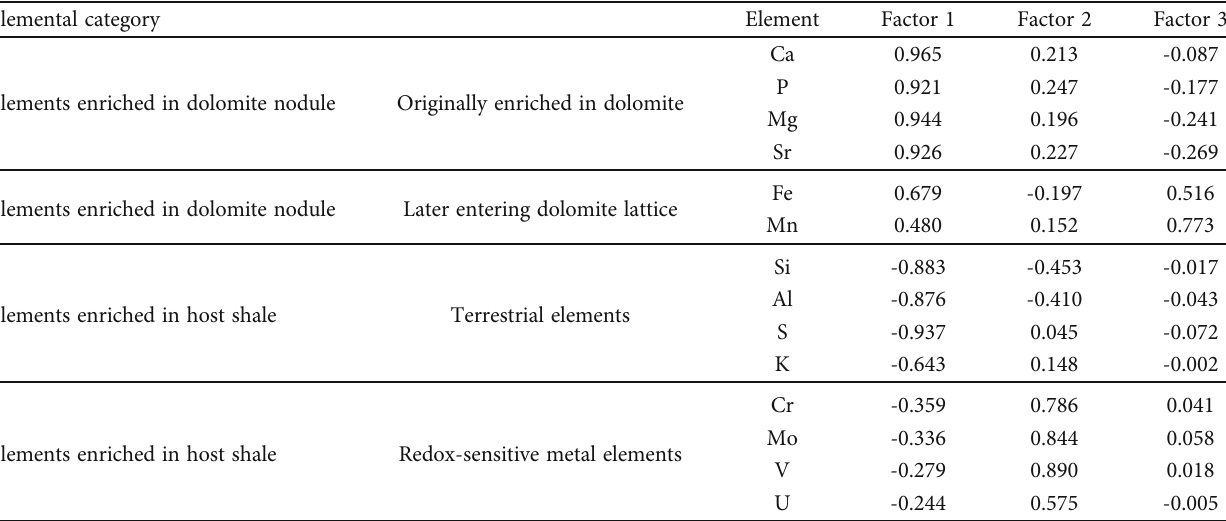
Table 3: Rotated factor loading matrix by PCA and the categorized element